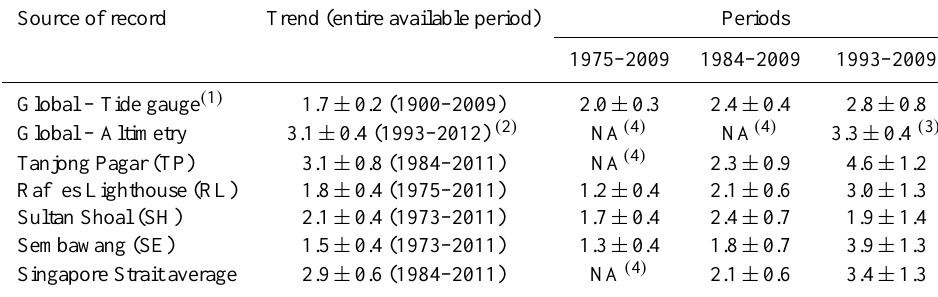
Table 1. Linear trends of sea level rise (mmyr − 1 ) over selected periods. Source of record Trend (entire available period) Periods